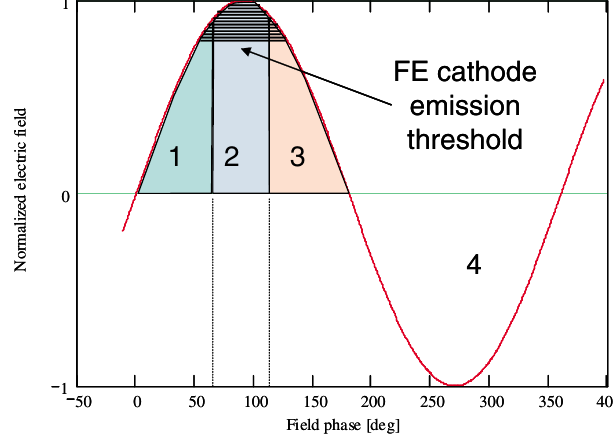
FIG. 3. (Color) FE cathode emission times during the rf period. The shaded region indicates the FE emission time.